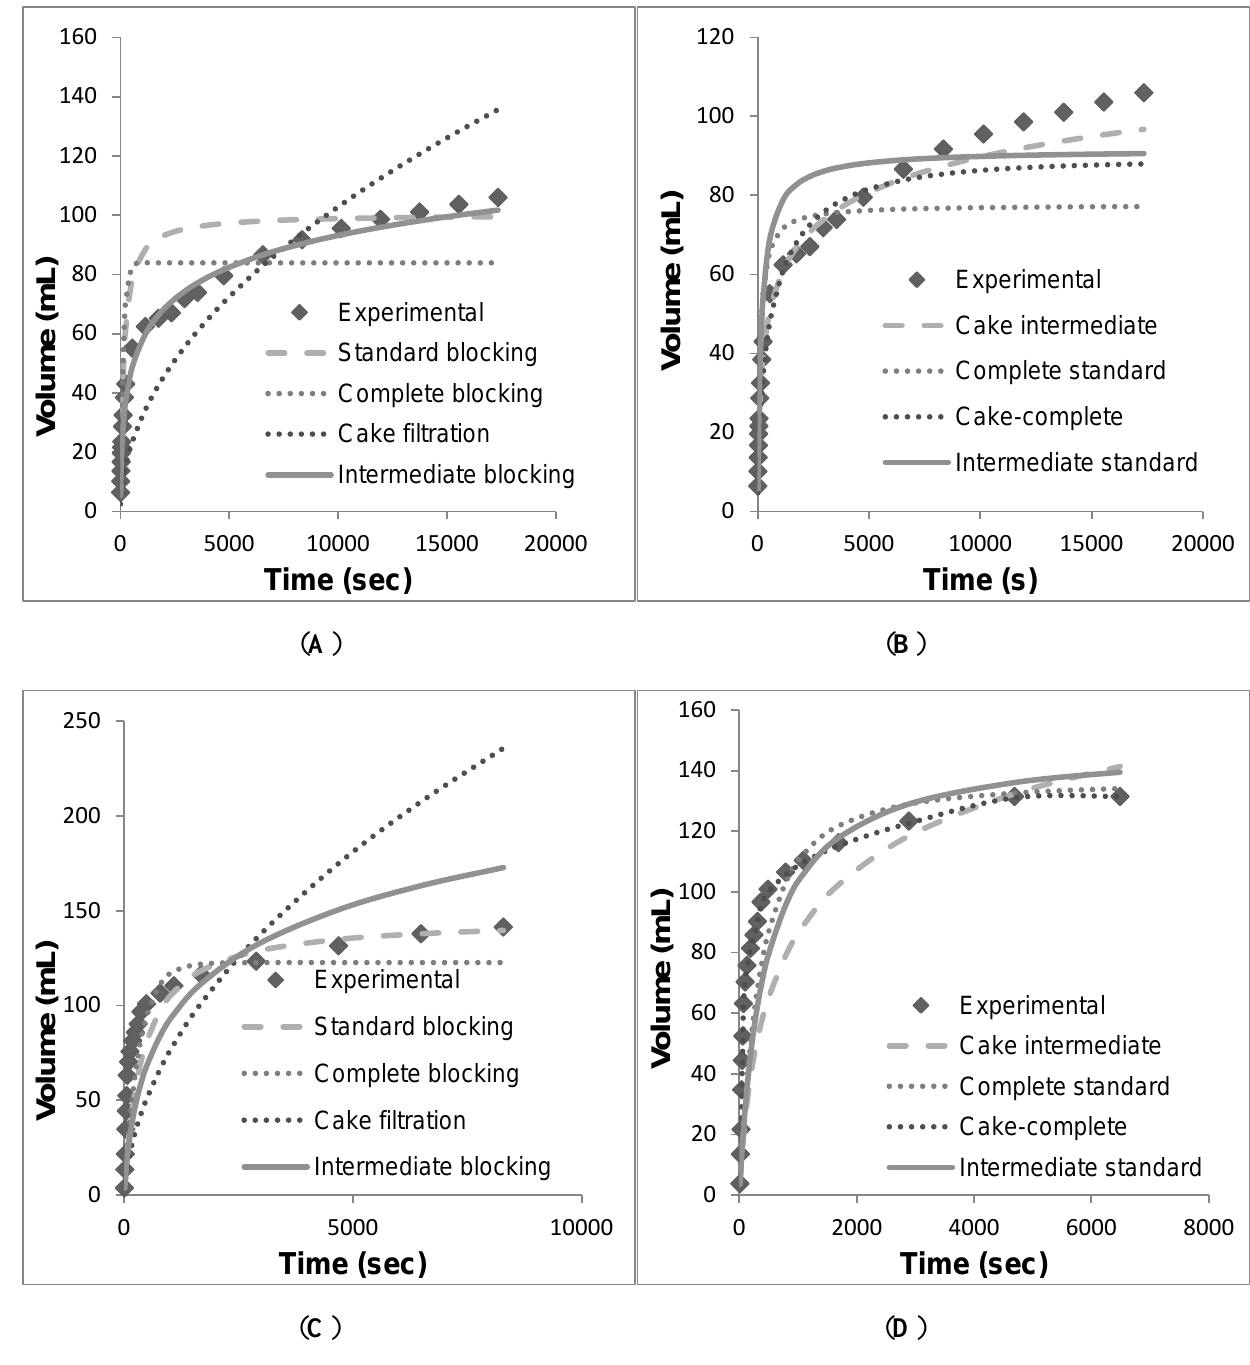
Figure 6. Volume vs. time data for individual models fit against the individual and combined models. ( A ) Individual models for EKMP. ( B ) Combined models for EKMP. ( C ) Individual models for KS50P. ( D ) Combined models for KS50P. ( E ) Individual models for EKSP. ( F ) Combined models for EKSP. ( G ) Individual models for PDD1. ( H ) Combined models for